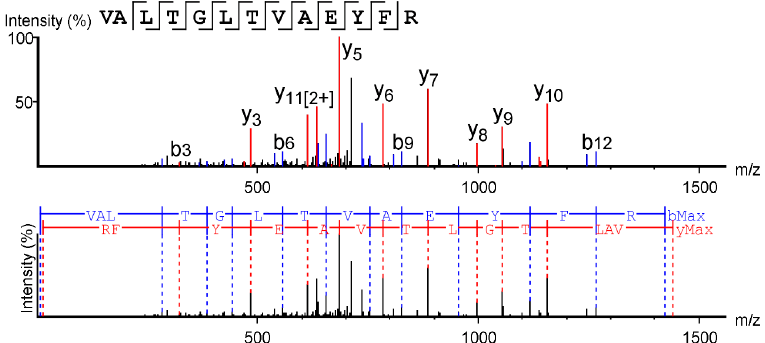
Figure 3. Mass spectrometry (MS/MS) fragmentation was used to obtain the complete sarconesin II aa sequence. The CID spectrum from mass/charge ( m/z ) of its double-charged ion gave [M + 2H] 2+ , m/z 720.3984. The ions from y (red) and b (blue) series (marked at the top of the spectrum) represent the primary structure: VALTGLTVAEYFR.